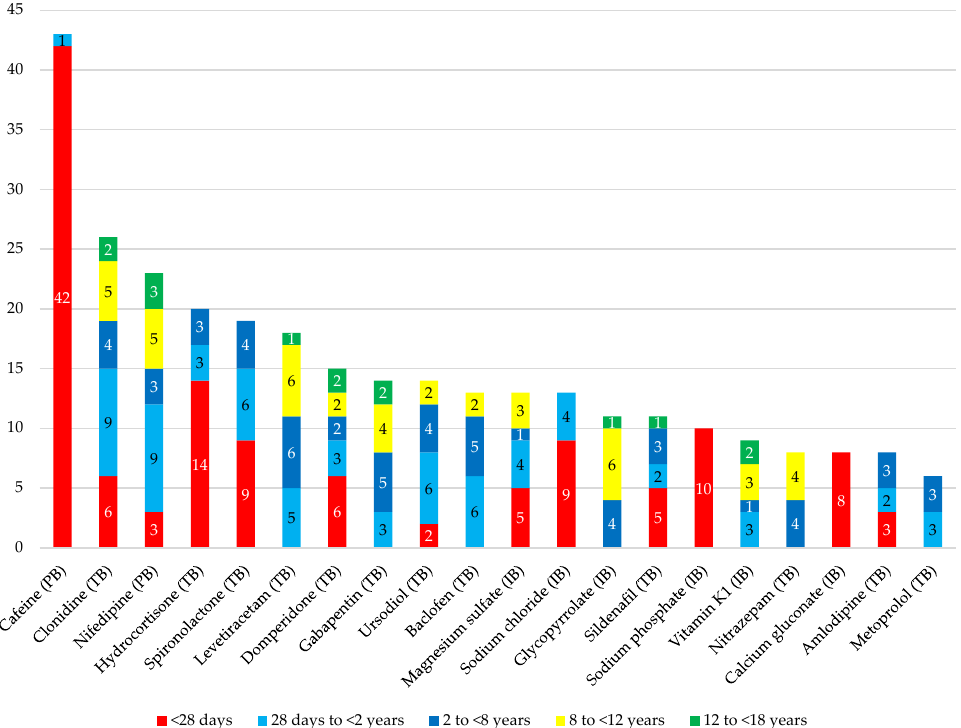
Figure 2. Twenty most prescribed liquid CDEA in the total population. Abbreviations: IB, injectable-based oral solution; PB, powder-based solution, suspension, or syrup; TB, tablet-based solution, suspension, or syrup.